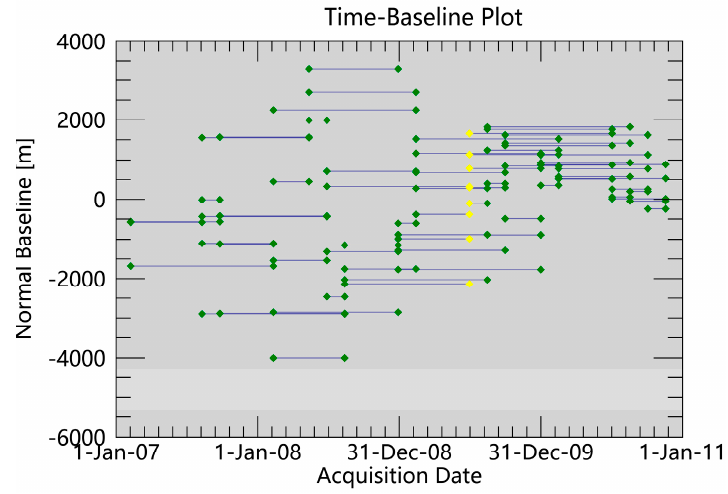
Figure 9. Time-Baseline map of ALOS PALSAR ascending data.